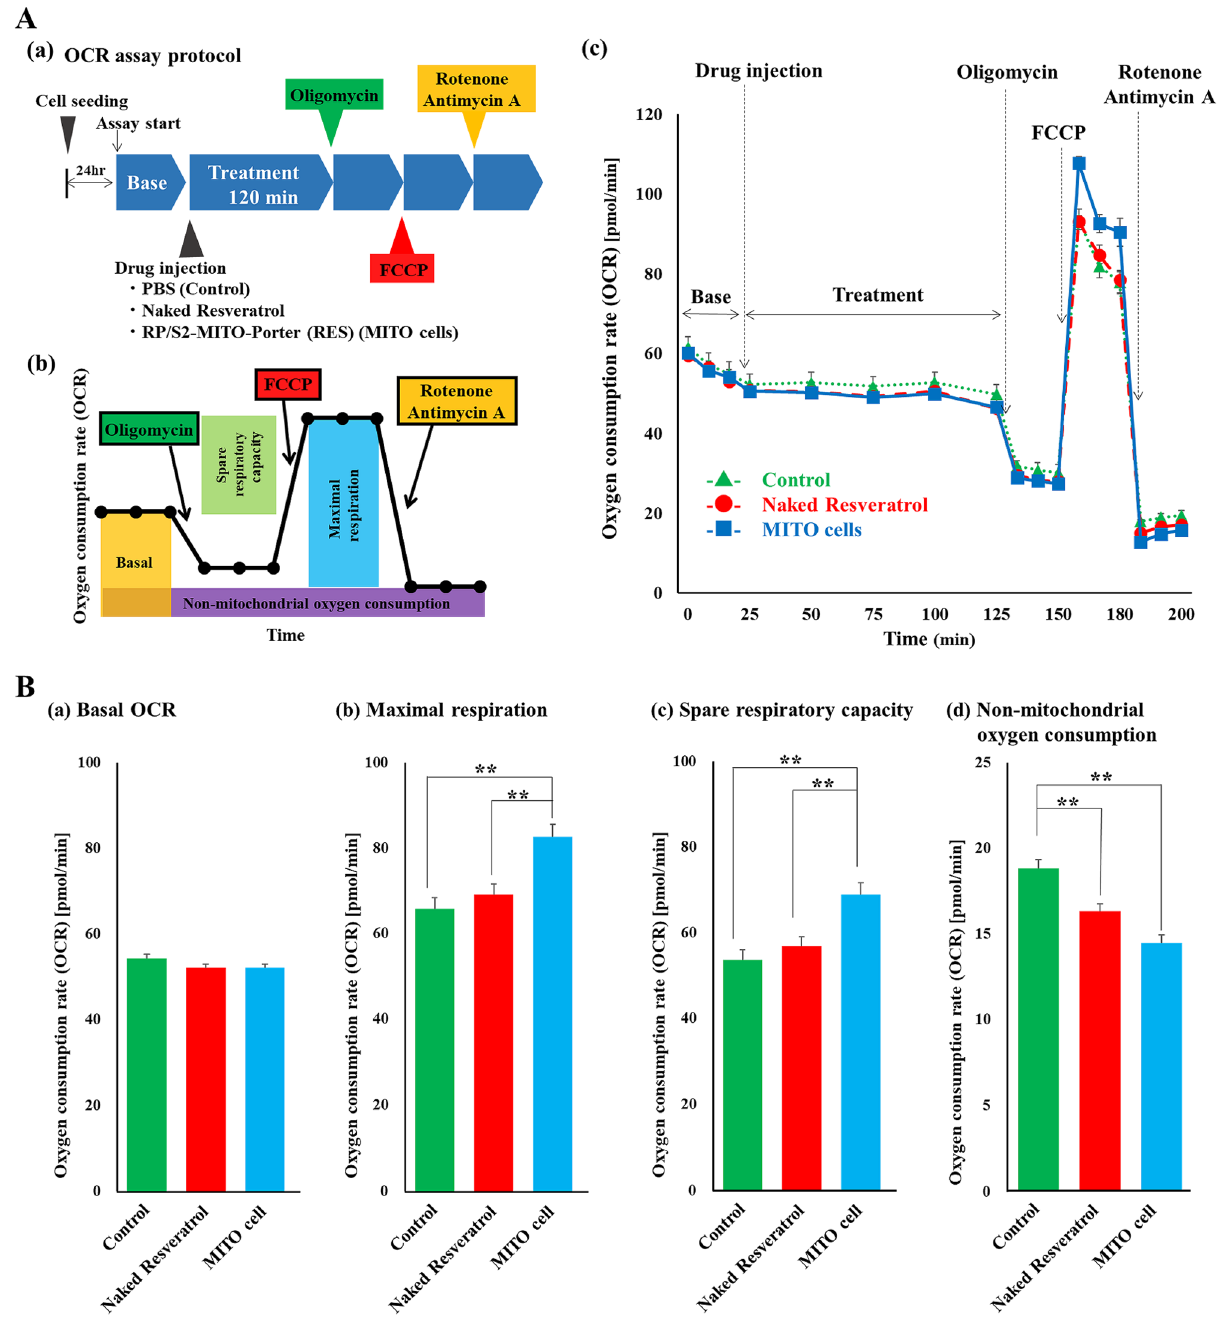
Figure 4. Evaluation of the mitochondrial function of MITO cells by measuring extracellular flux analyzer. The extracellular flux analyzer provides a continuous quantitative assessment of mitochondrial respiration in CPCs by measuring oxygen consumption. The Seahorse FXp was used to measure the mitochondrial oxygen consumption rate (OCR) of CPCs based on the protocol shown in ( A )( a ). Basic OCR, ATP-linked OCR, maximum OCR and non-mitochondrial OCR were measured. These parameters were estimated by the sequential addition of oligomycin (an inhibitor of ATP synthesis), carbonyl cyanide p-trifluoromethoxy- phenyl-hydrazone (FCCP) (a mitochondrial inner membrane decarboxylator that maximizes the mitochondrial electron transfer system), and rotenone and antimycin A (the complete inhibition of mitochondrial respiration) and the OCRs were measured ( B ). Significant differences were calculated using one-way ANOVA followed by the SNK test (**p < 0.01) (n =